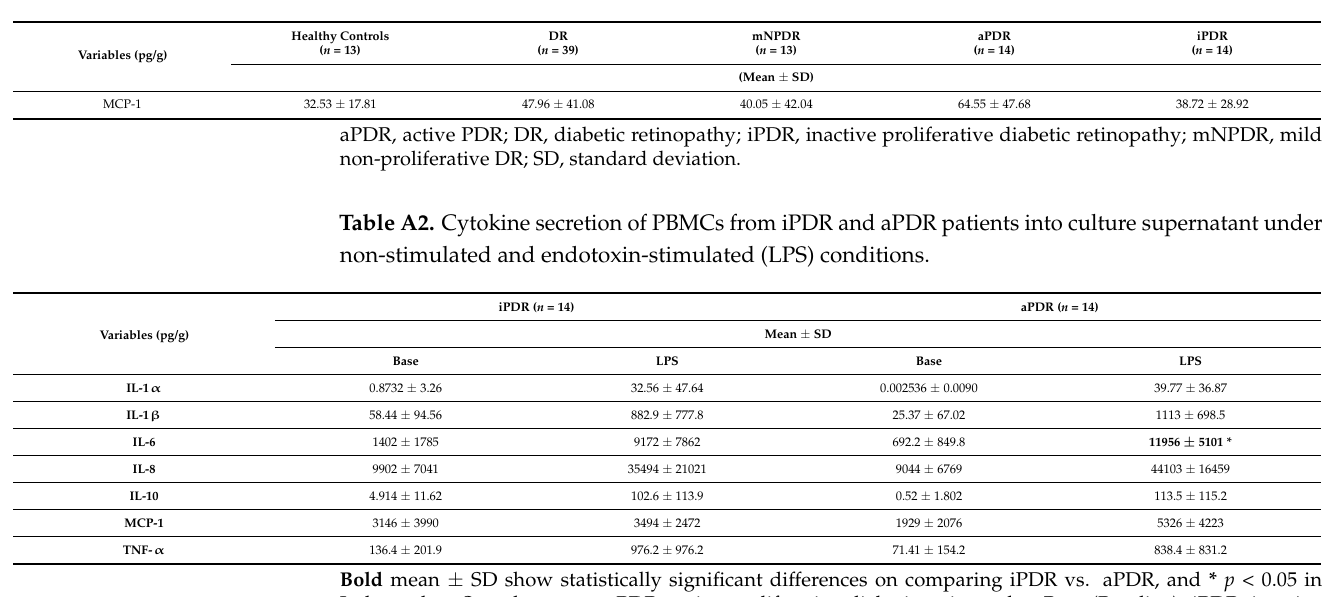
Table A1. MCP-1 expression in plasma of DR patients and controls. Independent Samples t -test.